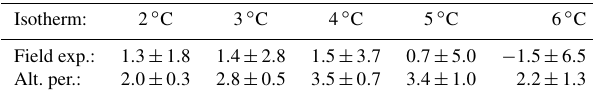
Table 4. Results from a sensitivity analysis, listing estimated aver- age values for the overflow transport per unit length at site B, q 0 , in units of m 2 s − 1 during the field experiment and during the altime- try period for different choices of the isotherm defined as the top of the overflow layer. Values for the altimetry period are calculated from regression coefficients determined similarly as for Fig. 13b. Uncertainties are 95% confidence intervals calculated from stan- dard errors after correction for serial correlation (Sect.